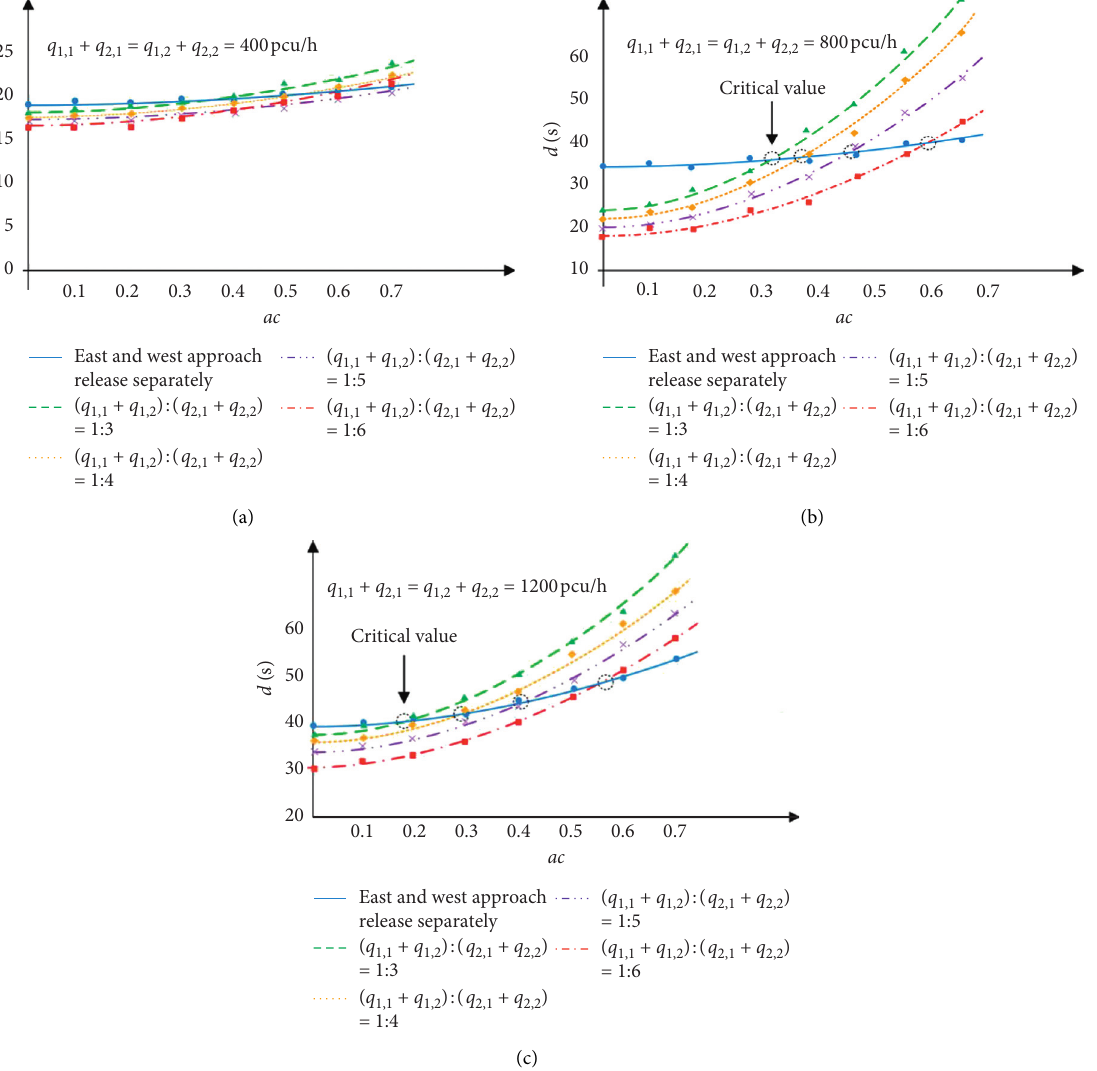
Figure 7: Simulation results of average delay versus changing asymmetric coefficient under different traffic volumes. (a) Average delay under low traffic volume. (b) Average delay under medium traffic volume. (c) Average delay under high traffic volume.